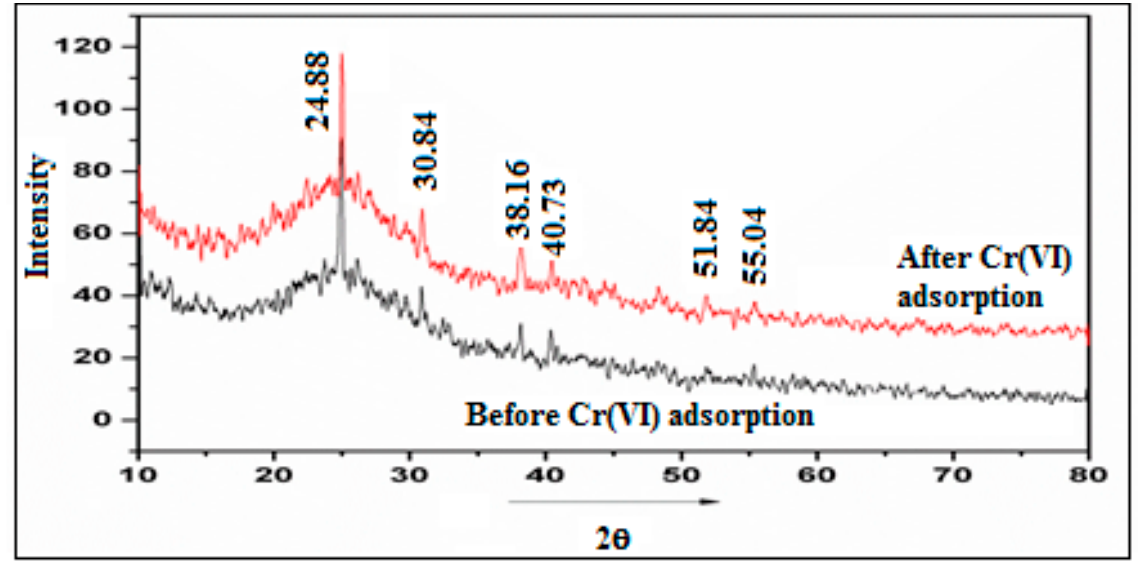
Figure 4. XRD images of Al-GNSC before, and after Cr(VI) adsorption.